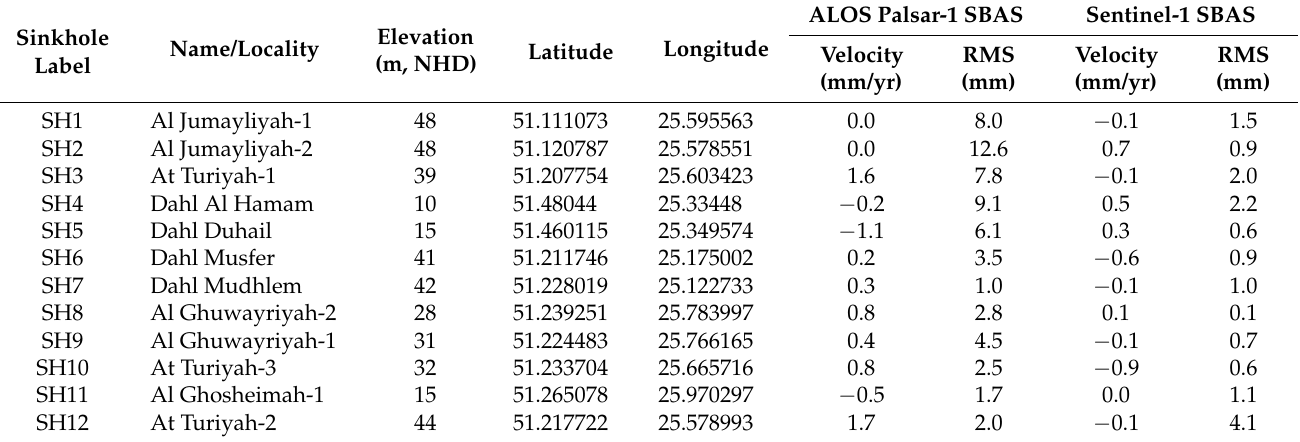
Table 2. Sinkholes, their locations, and the deformation rates calculated over the sinkholes using ALOS Palsar-1 and Sentinel-1